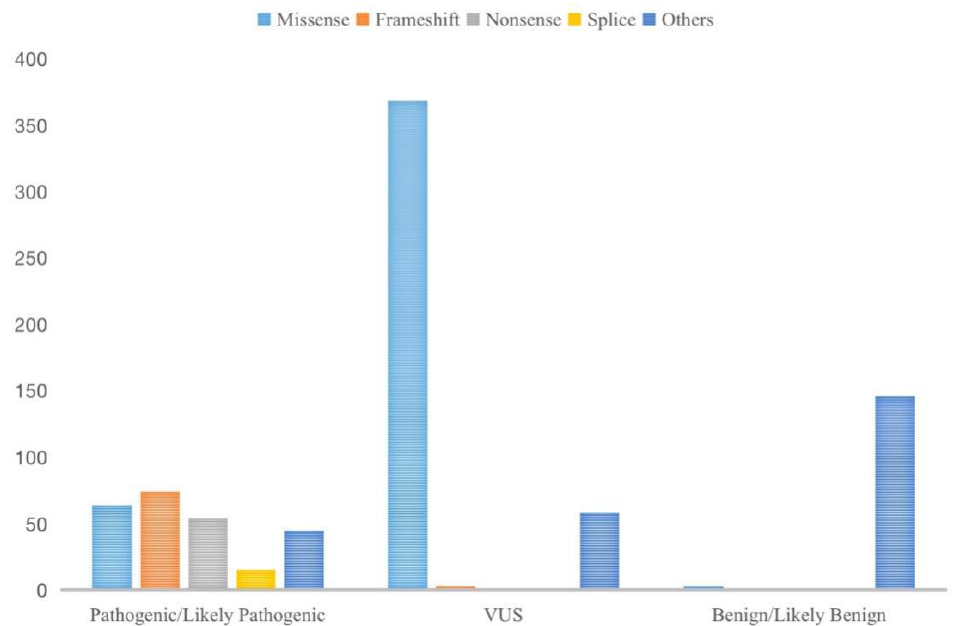
Figure 12. The proportion of different variants in FH sorted by clinical significance and different variant types in pathogenic and likely pathogenic variants.